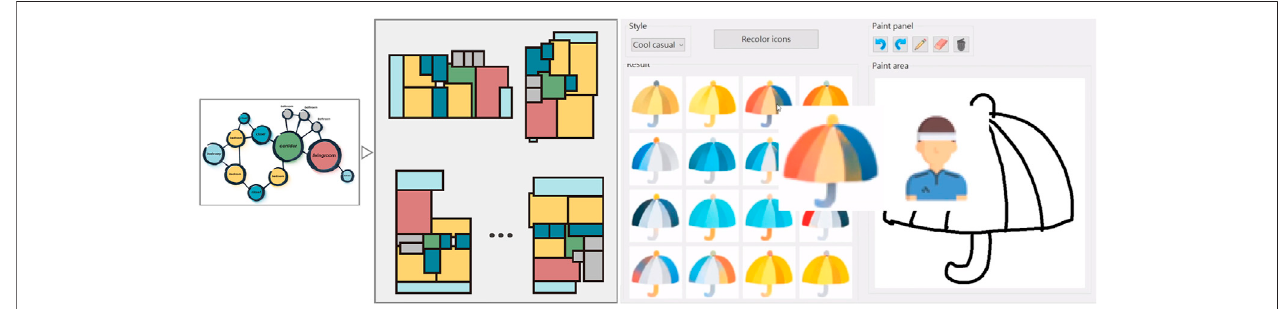
FIGURE 6 | Left: The interface for the HouseGAN system (Nauata et al., 2020). The user describes a node-graph, with nodes representing rooms and edges the connectionsbetweenthem.Thesystemoutputsavarietyofdesignsbasedonthegraphandtheusercanthenfurtheriterateanddesigntoreacha fi nal fl oorplan. Right: IntheworkbySunT.-H.etal.(2019),theauthorsdevelopedaninterfacetohelpdesignersdevelopdigitalicons.Theuserspeci fi esasketchandastyletheywouldliketo follow. The system then outputs icons based on the input sketch and style in a variety of